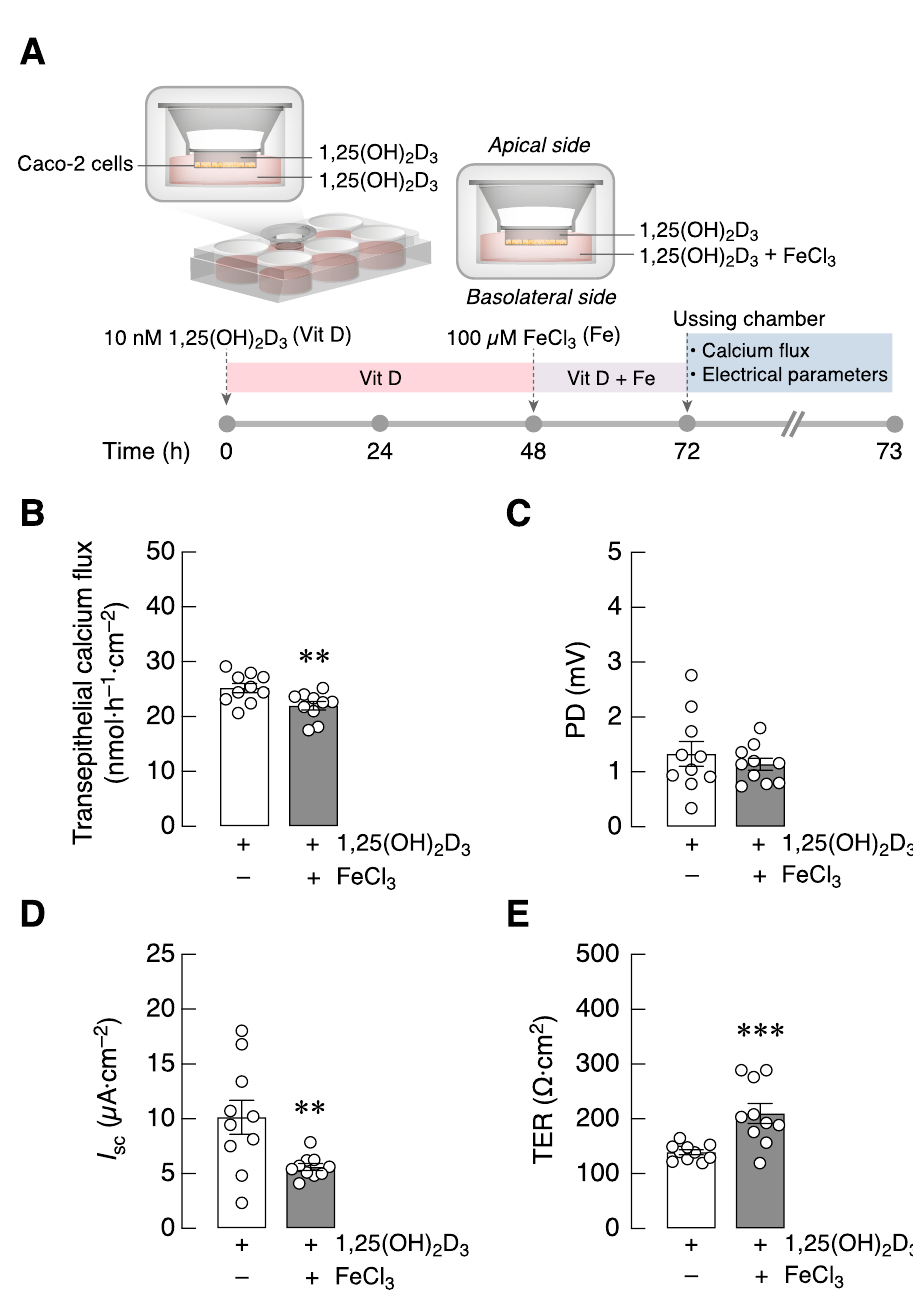
Fig 2. Transepithelial calcium flux of FeCl 3 and 1,25(OH) 2 D 3 -treated Caco-2 monolayer. (A) Experimental timeline of 1,25(OH) 2 D 3 and FeCl 3 treatment (please see text for detail). (B–E) Transepithelial calcium transport and epithelial electrical parameters (PD, I sc , and TER) in 1,25(OH) 2 D 3 -treated Caco-2 monolayers with or without 100 μ M FeCl 3 . PD values were the magnitudes of potential difference (the apical side being negative with respect to the basolateral side), and glucose made the apical side more negative. (n = 10; �� P < 0.01; ��� P < 0.001 compared with the control group (white